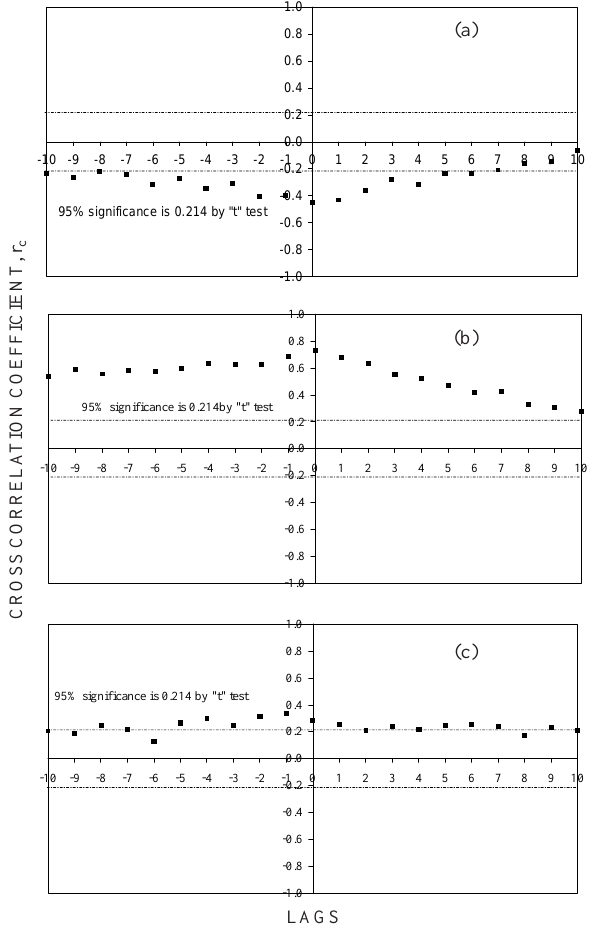
Figure 3. Calculated crosscorrelogram function (CCF) between soil water content and soil organic matter data (a); soil water content and clay content data (b); and soil water content and aggregate stability data (c).